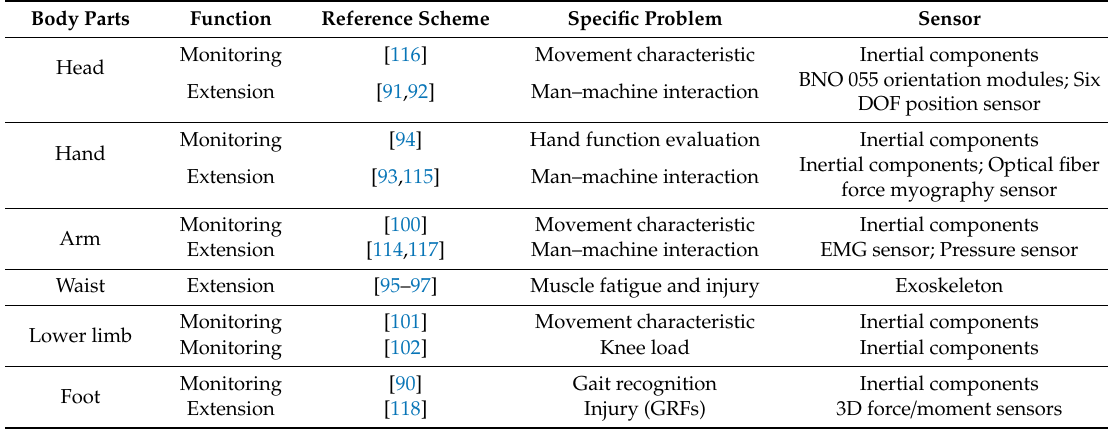
Table 4. Research problems based on di ff erent body